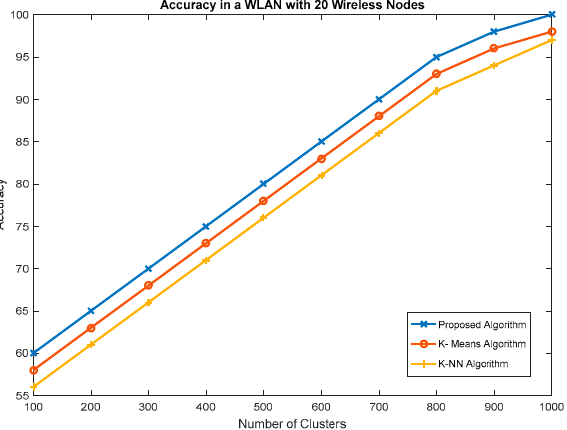
Figure 7. Accuracy versus of the number of clusters.